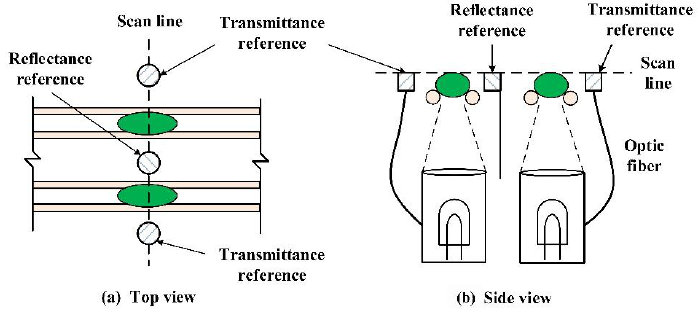
Figure 13. Schematic of reflectance and transmittance references for in-line light correction.